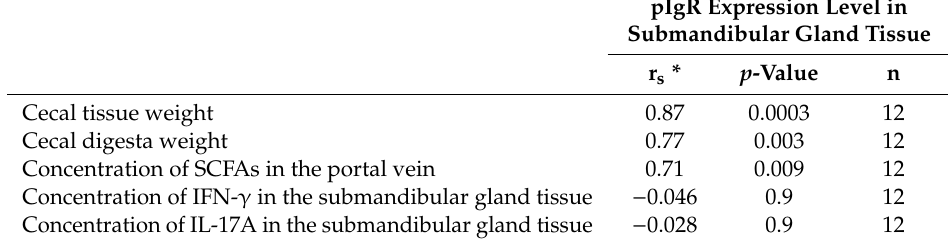
SCFAs: Short-chain fatty acids, which was the sum of the concentration of acetate, propionate, and n -butyrate. * Spearman’s rank correlation coefficient.